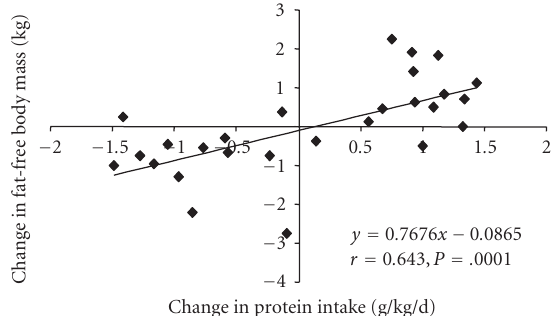
Figure 1: Combined plot showingthe relationshipbetween changes in protein intake and changes of fat-free body mass (FFM) of 14 young healthy women after consumption of diets for 4wks containing either additional meat (M, 200g pork fillet/d) or exclusion of all meat products (NOM). Individual di ff erences have been computed for each of the 14 subjects after each 4 weeks period relative to previous period, namely, baseline or end of first intervention period. Calculations of protein intake were based on 4-d food records. One value of FFM which was obviously an outlier was excluded. Table 1: Characteristics of women at baseline and after 4 weeks additional meat intake (M, 200g pork fillet/d) or exclusion of meat products (NOM).